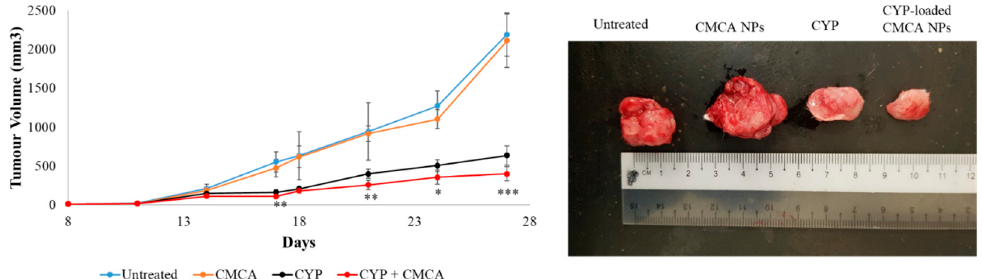
Figure 4. Treatment effects of free CYP, CYP-loaded CMCA NPs, and drug-free CMCA NPs compared to the untreated group of mice. Tumor picture was taken at day 27 after the mice were sacrificed humanely via euthanasia. Values were significant (*) at a p -value of 0.01 to 0.05, very significant (**) at a p -value of 0.001 to 0.01, and highly significant (***) at a p -value of 0.0001 to 0.001 vs. the same treatment with free CYP at a CI of 95%.